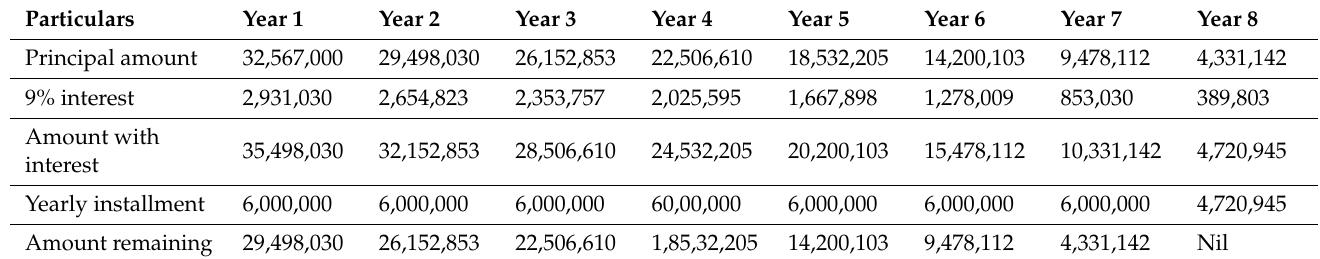
Table 5. The calculation of bank debts and the successful payment of the debts in time. (Figures in